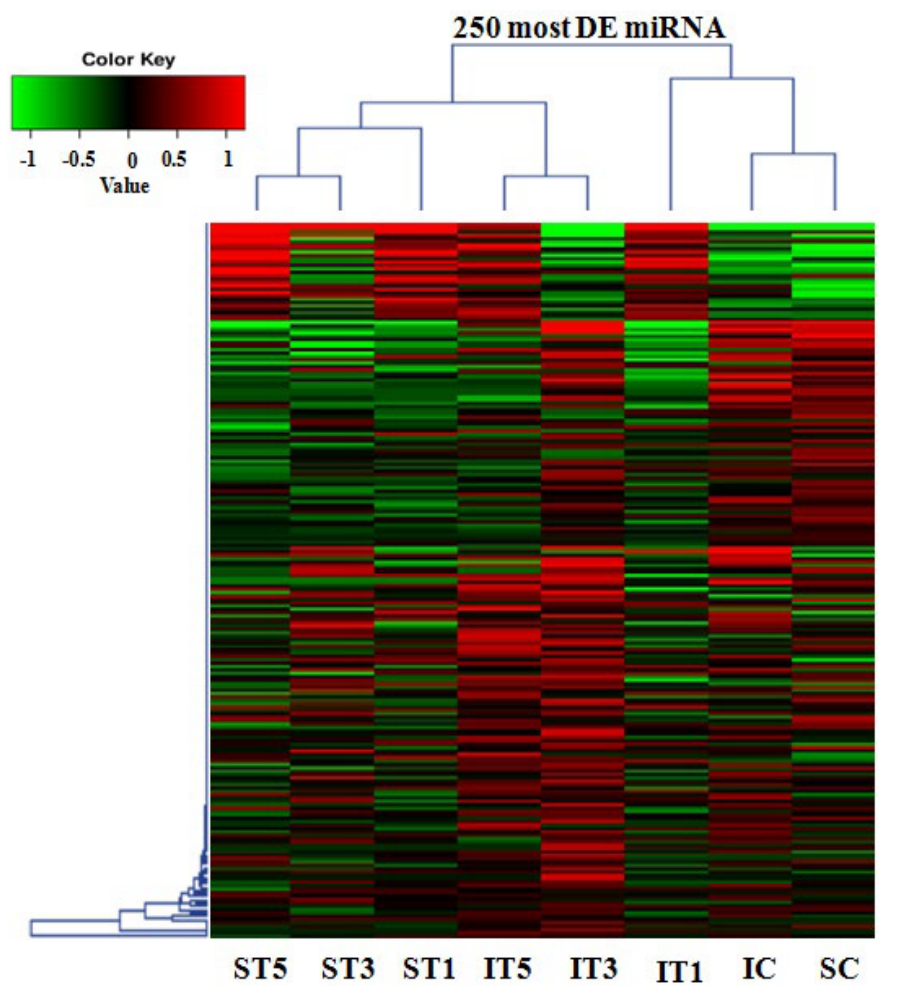
Figure 3. The heatmap of the 250 most differentially expressed (DE) miRNAs. Cluster analysis was performed using the log 2 (FPKM + 1) value from larger to smaller. The green color indicates downregulated miRNAs while the red color shows upregulated miRNAs. IC-IR8 control (untreated); IT1-